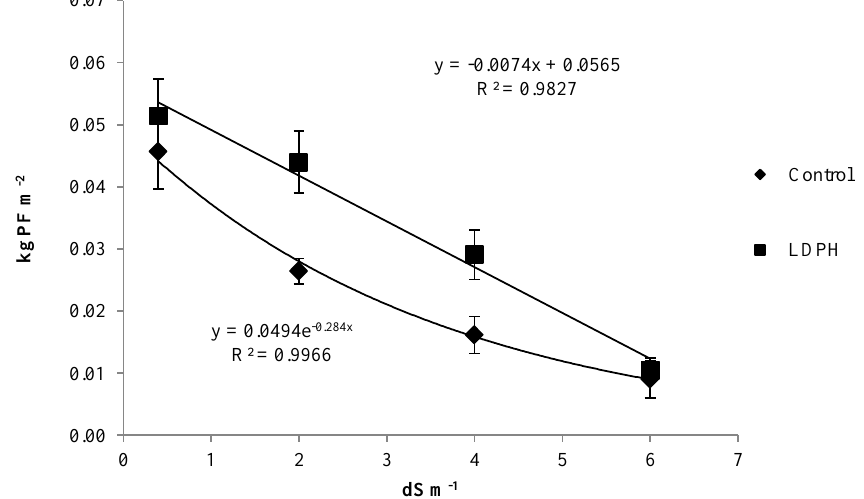
Figure 2. Seeds production of hemp as affected by saline water irrigation (EC0 = non-saline water; EC2 = water at 2.0 dS m −1 ; EC4 = water at 4.0 dS m −1 ; EC6 = water at 6.0 dS m −1 ) and biostimulant application (treated with a commercial legume-derived protein hydrolysate (LDPH) and non-treated (control)).